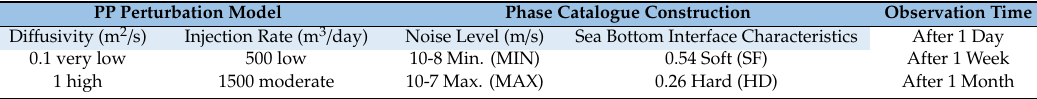
Table 2. Details regarding the variable parameters in the rock